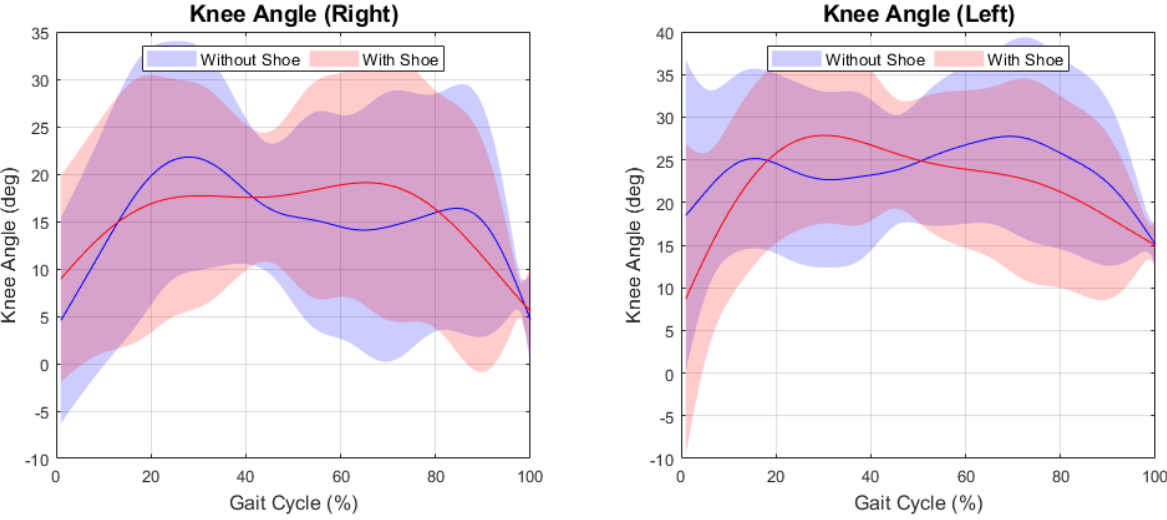
Figure 5. Knee kinematics of flatfoot subjects with and without shoes. Red line indicates mean knee joint angle with shoe group and Blue line indicated mean knee joint angle without shoe